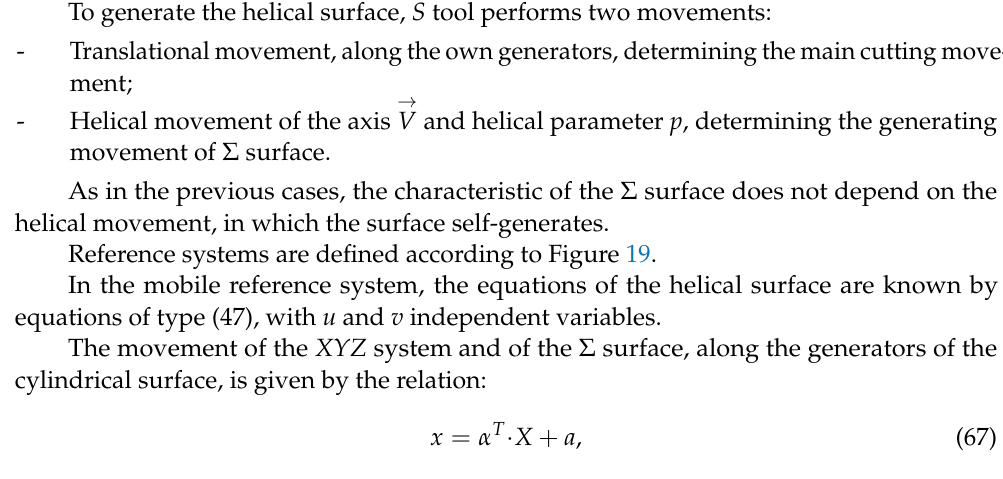
Figure 19. The relative position of the cylindrical (generating) and helical surfaces. Reference systems: XYZ represents the mobile reference system, joined with the helical surface; xyz —fixed coordinate system; the y -axis is parallel to the direction of the cylindrical surface generators; X’Y’Z’ —mobile reference system resulting from the movement of the XYZ system with the variable parameter δ .